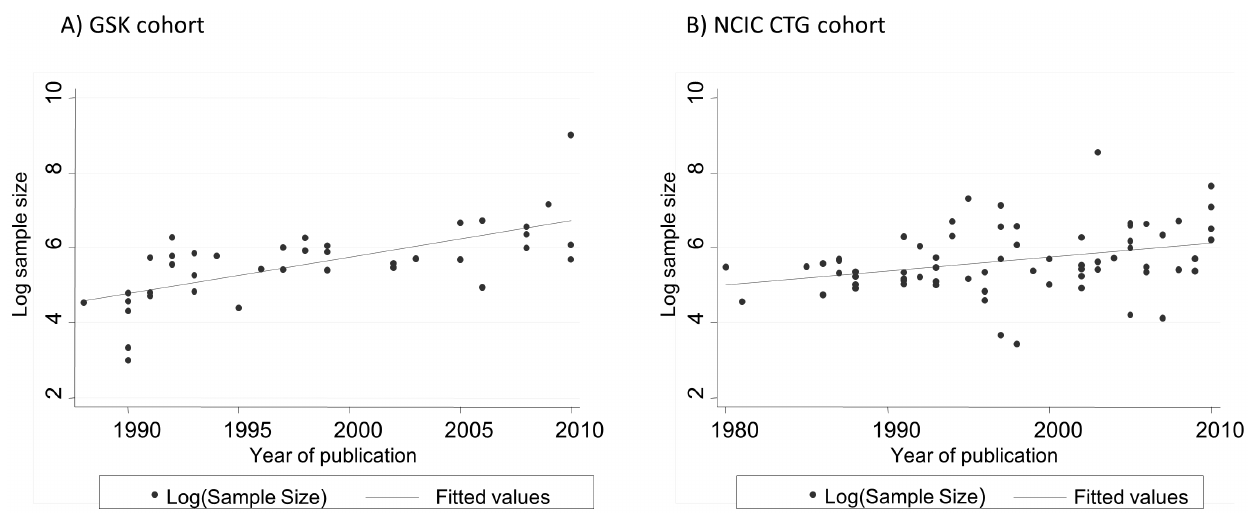
Figure 11. Change in sample size over time. There was an increase in the sample size over time both for National Cancer Institute Canada Clinical Trials Group (CTG) and GlaxoSmithKline (GSK) cohort. For CTG, on average, the sample size increased by 50% per decade, while for GSK, on average, it doubled. GSK trials were also somewhat larger than CTG trials: [median (range): 296 (20 to 8231) vs. 244 (31 to 5157); p=0.062]. Sample size was somewhat larger in GSK trials [median (range): 296 (20 to 8231) compared to 244 (31 to 5157); p=0.062]. It also increased over time in both cohorts. For CTG, on average the sample size increased by 50% per decade, while for GSK, on average, it doubled per decade. The average sample size increase (i.e. slope) was statistically significant between two cohorts (P , 0.001).